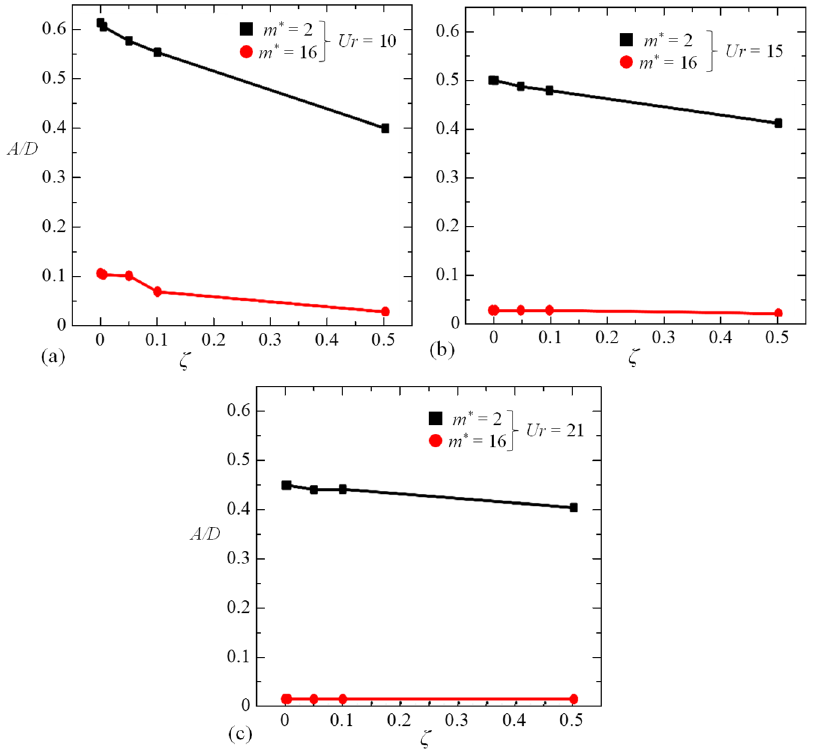
Figure 7. Effect of damping ratio ζ on vibration amplitude A/D at different m * and Ur . ( a ) Ur = 10, ( b ) Ur = 15, and ( c ) Ur = 21. L/D = 3 .